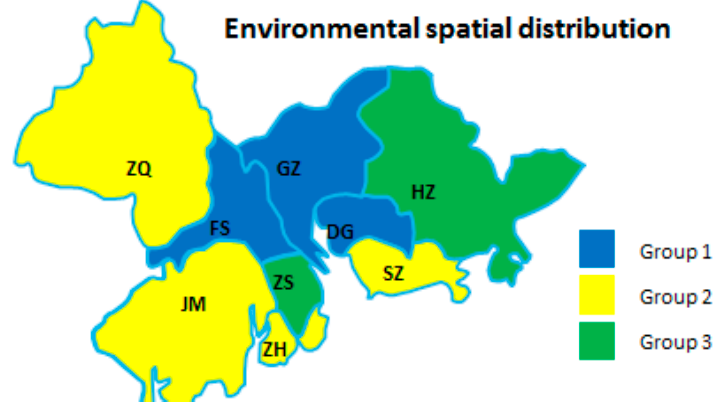
Figure 4. Environmental spatial distribution of the nine cities.